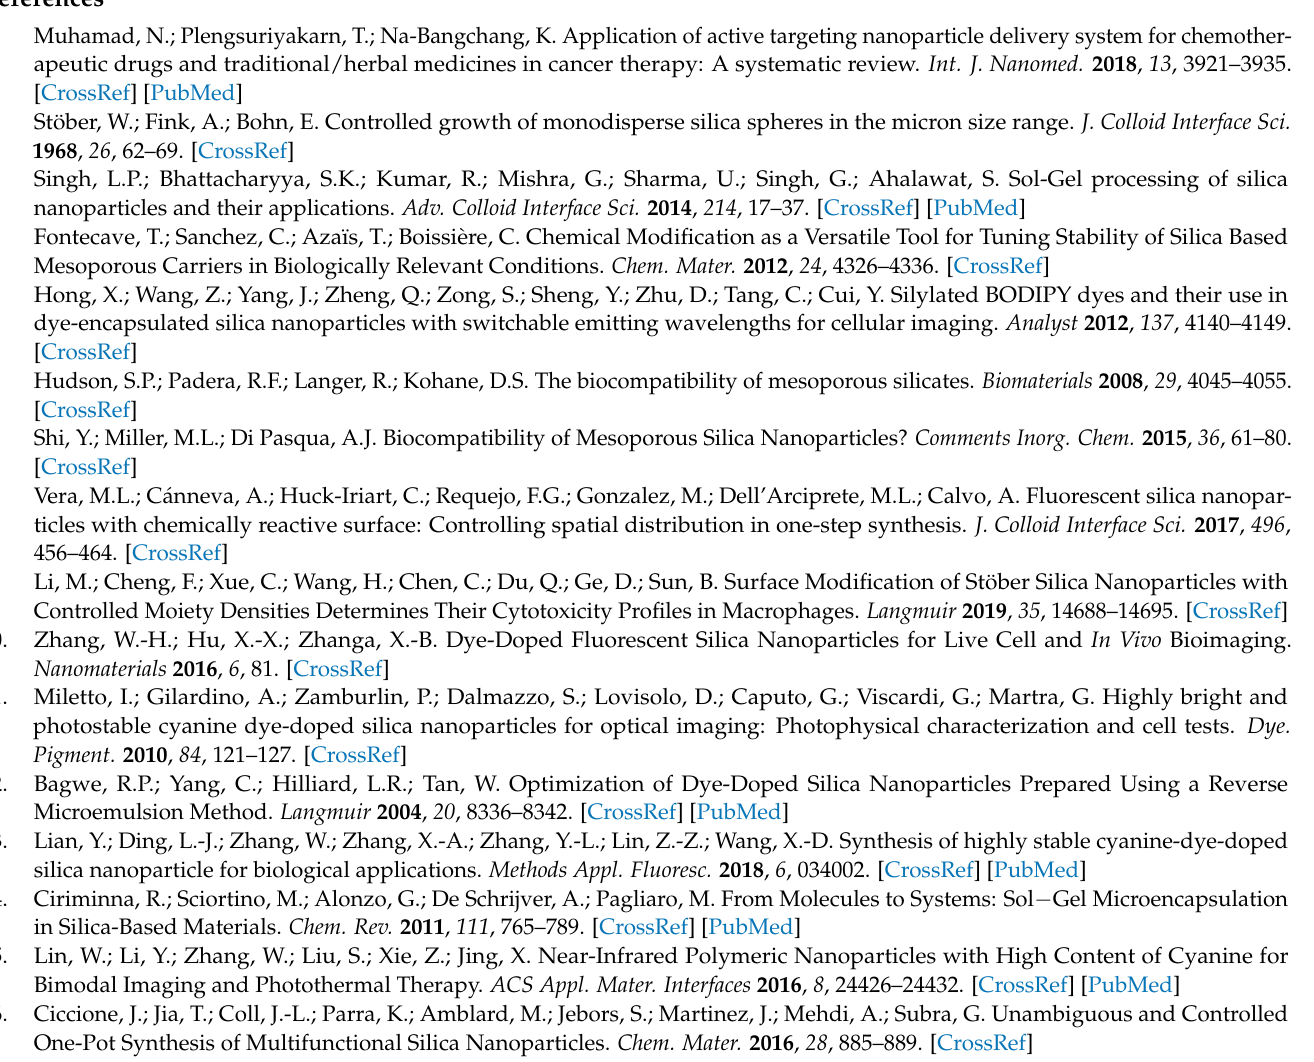
ibration curve for Cyanine 5.5 encapsulation. Figure S5: Aggregated dried SiNPs, Figure S6. type B vs. type D SiNPs. Figure S7: UV/Visible spectra of SiNPs types B , C , and D . Figure S8: UV/Visible spectra of SiNPs type B , SiNPs 1 , SiNPs 2 , and SiNPs 3